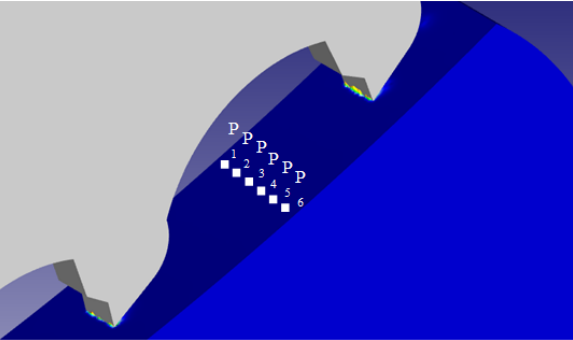
Figure 18. Temperature tracking point location.